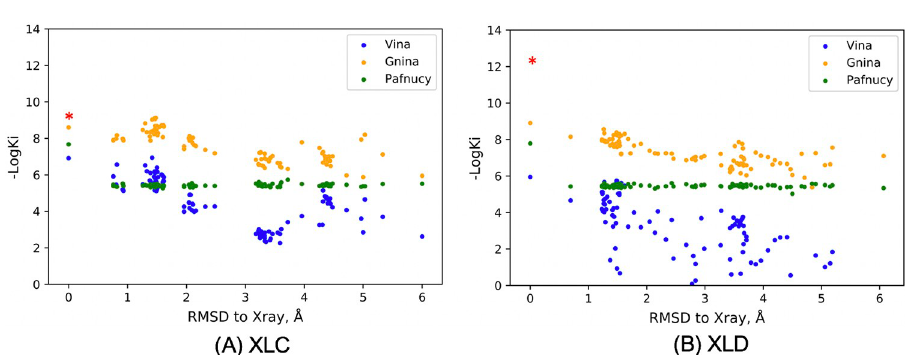
Fig 14. Pose sensitivity of Vina, Gnina and Pafnucy. The three models were tested on 100 re-docked poses of ligand XLC (A) and ligand XLD (B). The red asterisk at the RMSD = 0 marks the experimental affinity. Vina predicts free binding energy ( Δ G) in kcal/mol; here, we estimated the Ki at 25 Celsius using the equation Δ G = RTlnKi, where R is the gas constant (8.31 J/K � mol).